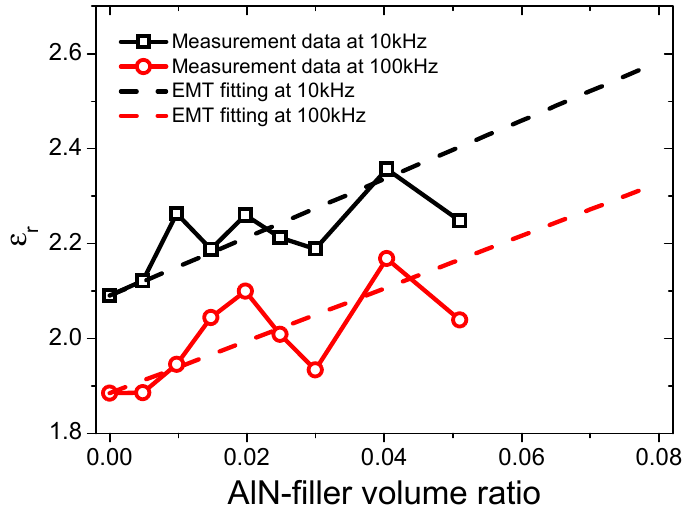
Figure 12. Fitting results for the dielectric constants of the AlN-filled silicon rubber composites based on the effective medium theory.